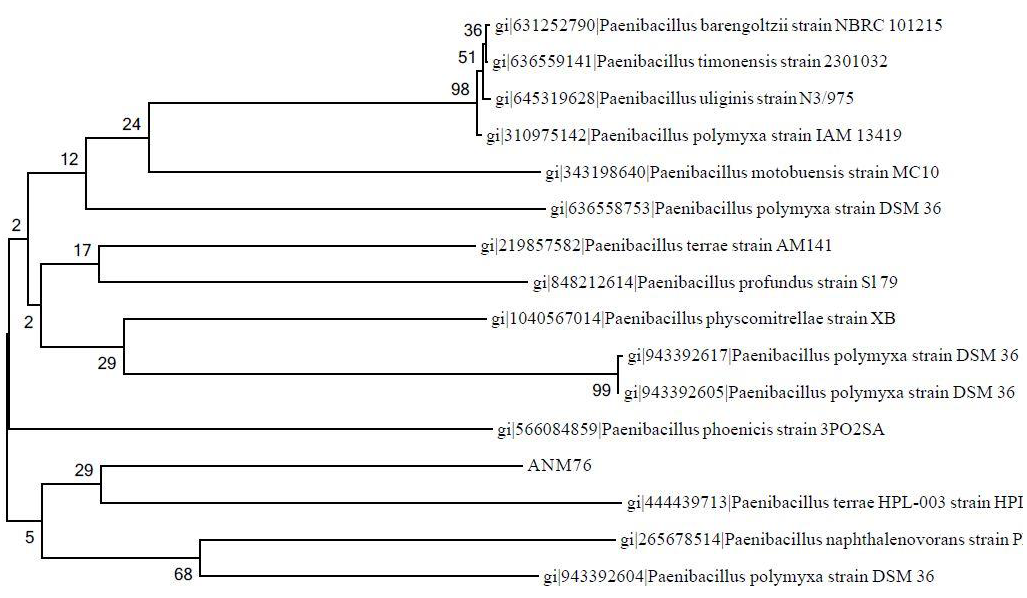
Figure 5. Neighbour-joining phylogenetic tree produced using multiple alignment of 16S rRNA gene sequence of Paenibacillus sp. ANM76 with those of other bacterial strains found in the GeneBank database.